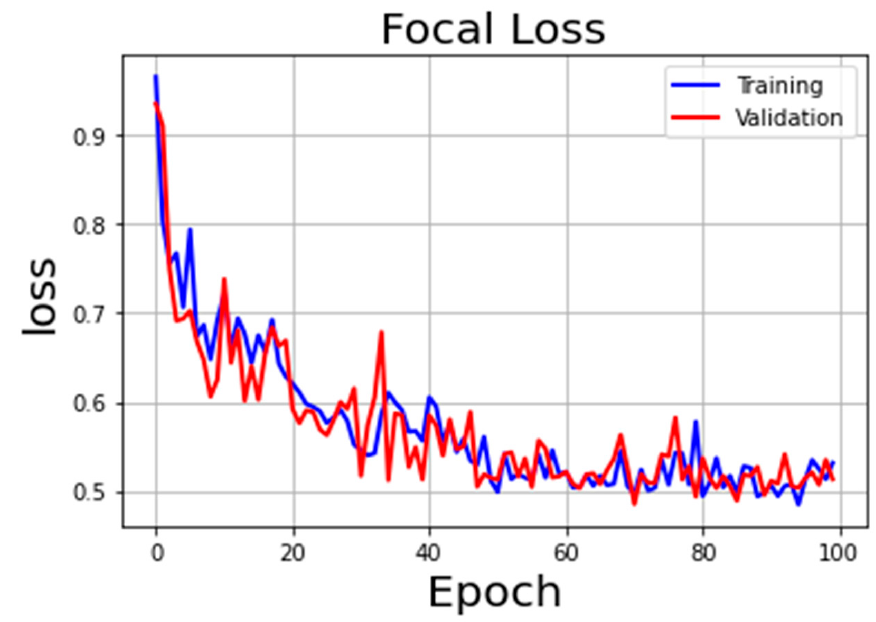
Figure 6. Focal Loss curve during training and validation.